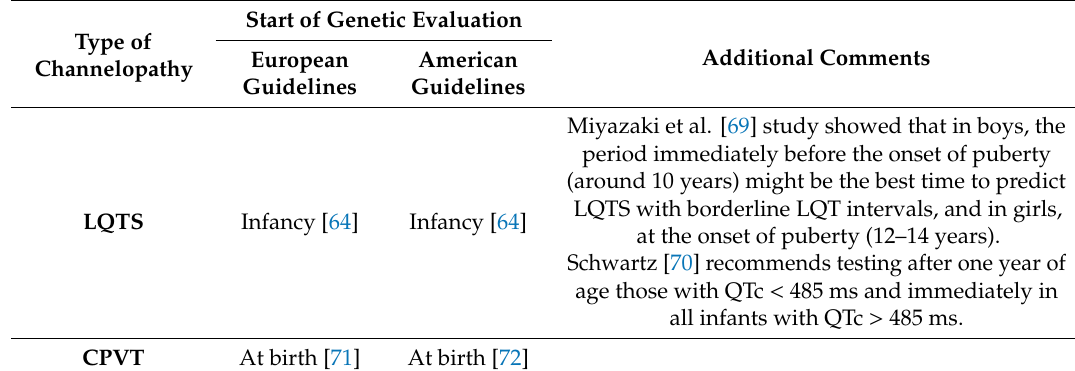
Table 3. Genetic screening of patients with